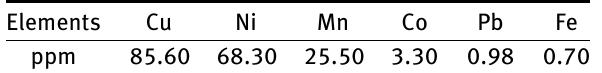
Table 5: Chemical compositions of